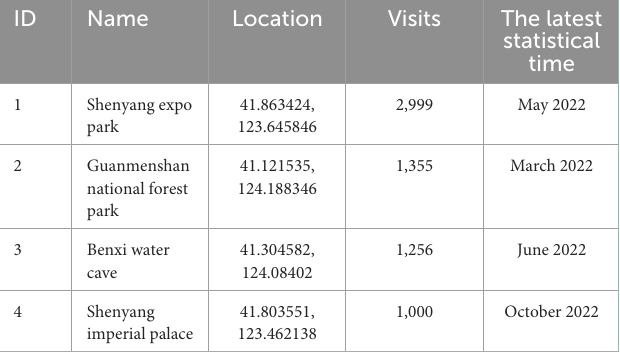
TABLE 3 Sample visit statistics based on attraction